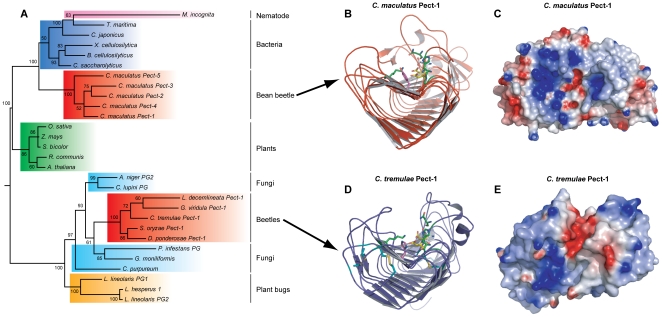
Beetle polygalacturonases (GH28) form two distinct clades, one more similar to those from bacteria and one more similar to those from fungi.
A, A Bayesian inferred phylogeny is shown which compares the predicted amino acid sequences of the beetle GH28 enzymes described here with those known from bacteria, fungi, nematodes and plants. Posterior branch probabilities are shown and similar groupings were recovered using both Neighbor-joining and maximum likelihood based algorithms. B, Modelled cartoon view and C, Electrostatic map of C. maculatus Pect-1 enzyme oriented to view through the catalytic cleft. The proton donor (Asp205) is shown in white, and the catalytic nucleophile/base residues (Asp184 and Asp206) are shown in yellow. Conserved residues (Asn182, His238, Gly239 and Lys271) most likely implicated in substrate binding are shown in green, whereas the non conserved residue Tyr269 (instead of Arg) is shown in magenta. D, Modelled cartoon view and E, Electrostatic map of C. tremulae Pect-1 enzyme oriented to view through the catalytic cleft. The proton donor (Asp185) is shown in white, and the catalytic nucleophile/base residues (Asp164 and Asp186) are shown in yellow. Conserved residues (Asn162, His207, Gly208 and Lys245), most likely implicated in substrate binding, are in green, whereas the non conserved residue His269 (instead of Arg) is in magenta. The four conserved disulfide bridges are shown in cyan.